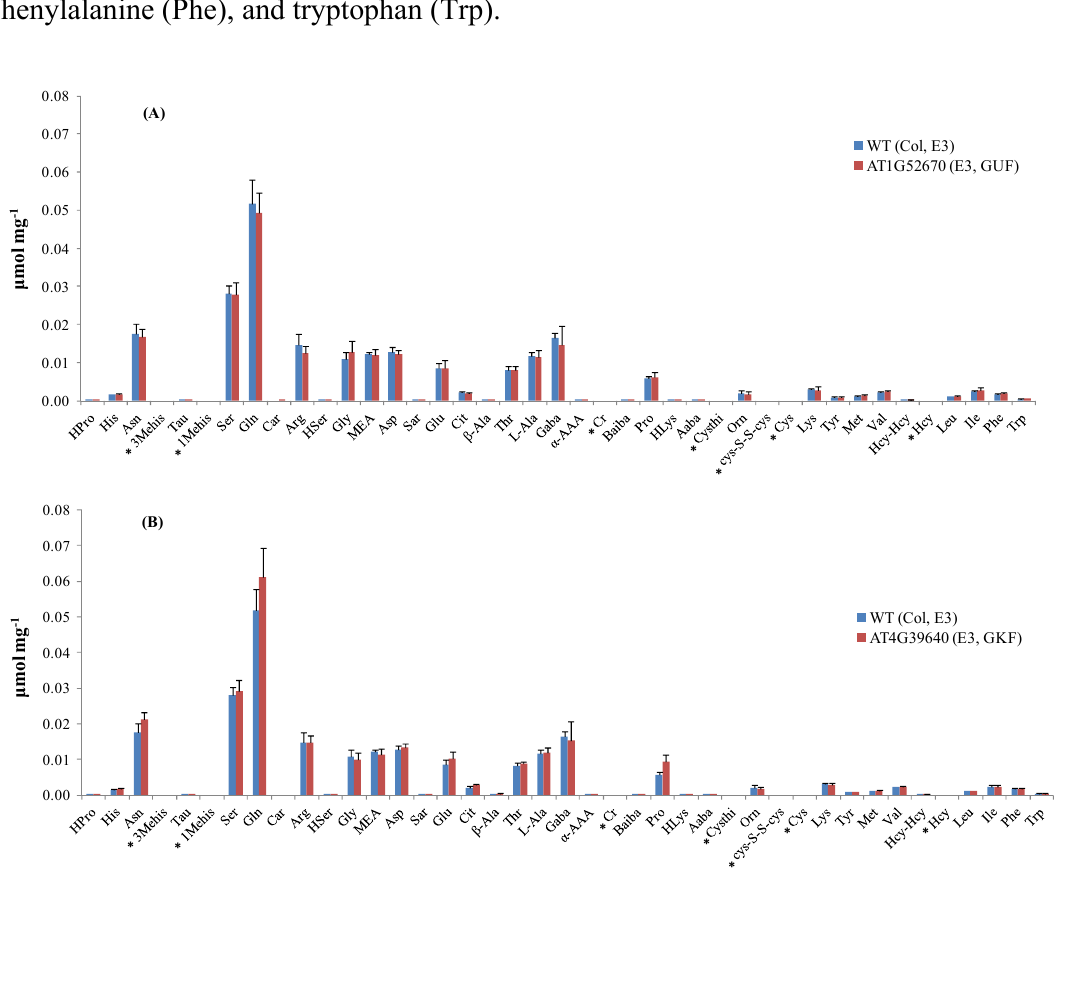
Figure 2. Amino acid profiles in Arabidopsis mutant stocks carrying T-DNA mutant alleles in GKF and GUF. ( A ) Concentration of amino acids ( μ mol mg − 1 dry weight) in mutant line SALK_021108 compared to its parental strain (wild-type). ( B ) Concentration of amino acids ( μ mol mg − 1 dry weight) in mutant line SALK_004694 compared to its parental strain (wild-type). Standard deviation bars calculated from six biological replicates. For information about Arabidopsis mutant stocks used in experiments E2 and E3 refer to ref. [7]. * Amino acids below LOD. GKF: gene of known function, GUF: gene of unknown function. Hydroxyproline (HPro), histidine (His), asparagine (Asn), taurine (Tau), 1-methyl-histidine (1-Mehis), serine (Ser), glutamine (Gln), carnosine (Car), arginine (Arg), homoserine (HSer), glycine (Gly), ethanolamine (MEA), aspartic acid (Asp), sarcosine (Sar), glutamic acid (Glu), citrulline (Cit), β -alanine ( β -Ala), threonine (Thr), L-alanine (L-Ala), γ -amino-n-butyric acid (Gaba), α -aminoadipic acid ( α -AAA), creatinine (Cr), β -aminoisobutyric acid (Baiba), proline (Pro), hydroxy-lysine (HLys), α - amino-n-butyric acid (Aaba), cystathionine (Cysthi), ornithine (Orn), cystine (Cys-S-S- cys), cysteine (Cys), lysine (Lys), Tyrosine (Tyr), methionine (Met), valine (Val), homocystine phenylalanine (Phe), and tryptophan